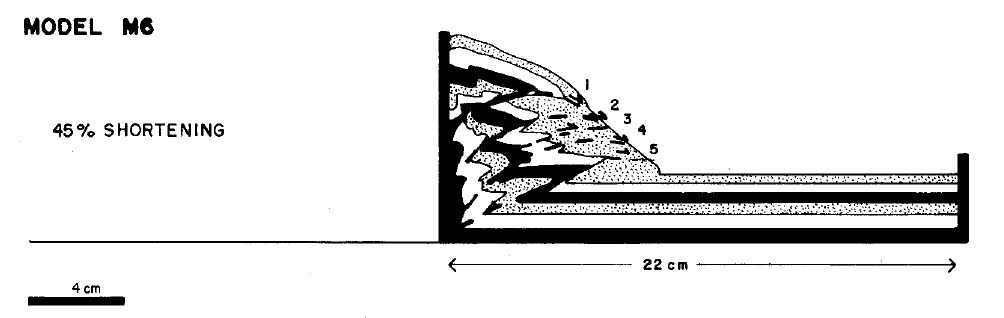
Fig. 16 – Model M6 with a high basal friction and a horizontal base, after 45% shortening. The high basal friction inhibits the displacement of the foreland, producing a compressional system characterized by strong vertical strain. Note the geometry of the bottom black layer.